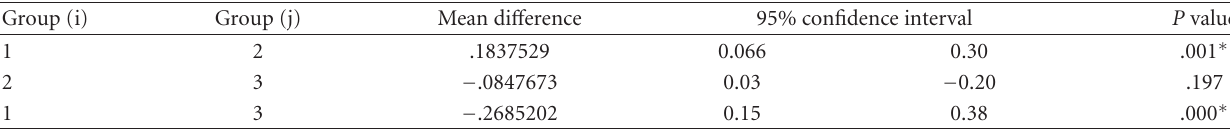
Table 2: Mean di ff erence in the debris ratio of the total canal between the three